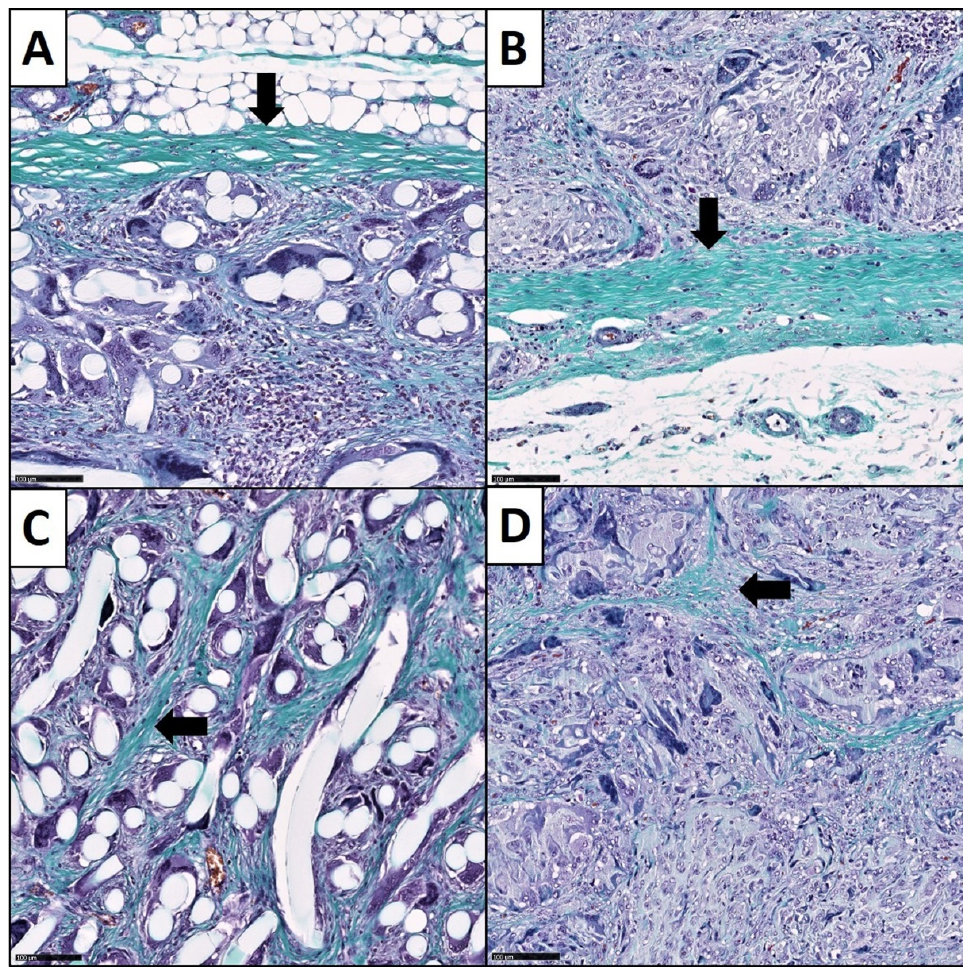
Figure 4. Histopathological evaluation of the fibrotic reactions of the macroporous biomaterials. ( A ) Fibrotic encapsulation (black arrows) around the surface of a filamentous fleece. ( B ) Encapsulation around the surface of a sponge-like biomaterial. Collagen fibers are arranged in parallel and stack in several layers. ( C ) Fibrotic ingrowth within the structure of the filamentous fleece. ( D ) Fibrotic ingrowth within a sponge-like biomaterial. Collagen fibers (arrow) are arranged in diffuse bundles in the space between the architectural elements (Masson-Goldner trichrome staining, magnification ×